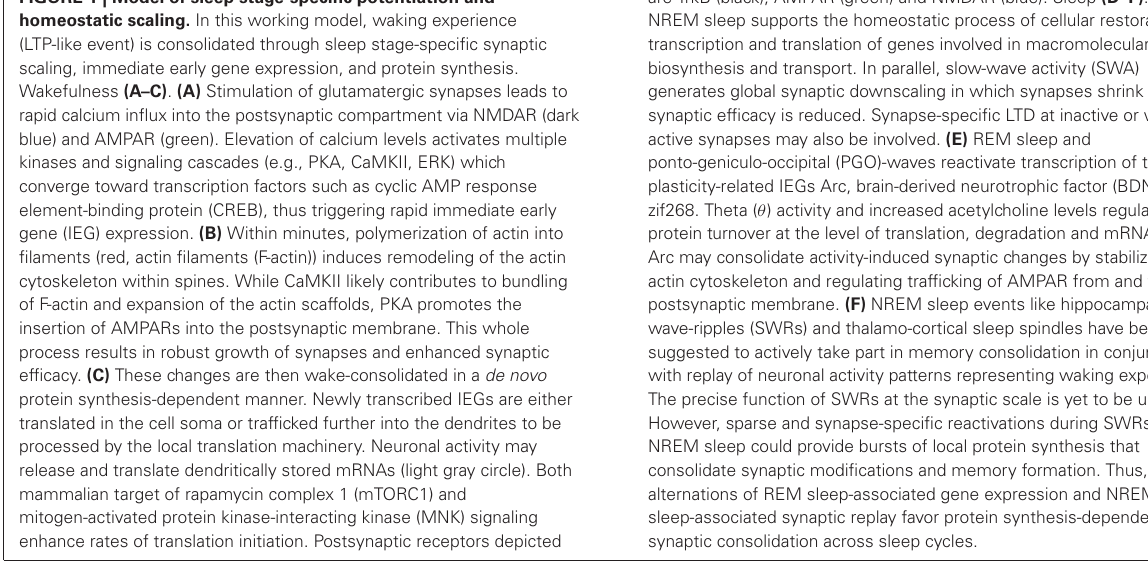
FIGURE 1 | Model of sleep stage-specific potentiation and homeostatic scaling. In this working model, waking experience (LTP-like event) is consolidated through sleep stage-specific synaptic scaling, immediate early gene expression, and protein synthesis. Wakefulness (A–C) . (A) Stimulation of glutamatergic synapses leads to rapid calcium influx into the postsynaptic compartment via NMDAR (dark blue) and AMPAR (green). Elevation of calcium levels activates multiple kinases and signaling cascades (e.g., PKA, CaMKII, ERK) which converge toward transcription factors such as cyclic AMP response element-binding protein (CREB), thus triggering rapid immediate early gene (IEG) expression. (B) Within minutes, polymerization of actin into filaments (red, actin filaments (F-actin)) induces remodeling of the actin cytoskeleton within spines. While CaMKII likely contributes to bundling of F-actin and expansion of the actin scaffolds, PKA promotes the insertion of AMPARs into the postsynaptic membrane. This whole process results in robust growth of synapses and enhanced synaptic efficacy. (C) These changes are then wake-consolidated in a de novo protein synthesis-dependent manner. Newly transcribed IEGs are either translated in the cell soma or trafficked further into the dendrites to be processed by the local translation machinery. Neuronal activity may release and translate dendritically stored mRNAs (light gray circle). Both mammalian target of rapamycin complex 1 (mTORC1) and mitogen-activated protein kinase-interacting kinase (MNK) signaling enhance rates of translation initiation. Postsynaptic receptors depicted